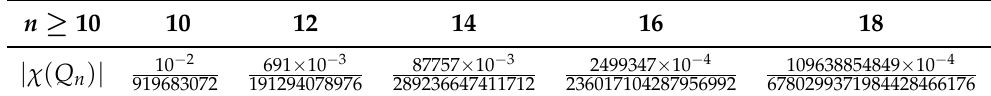
Table 4. The values | χ ( Q n ) | for even dimensions 10 ≤ n ≤